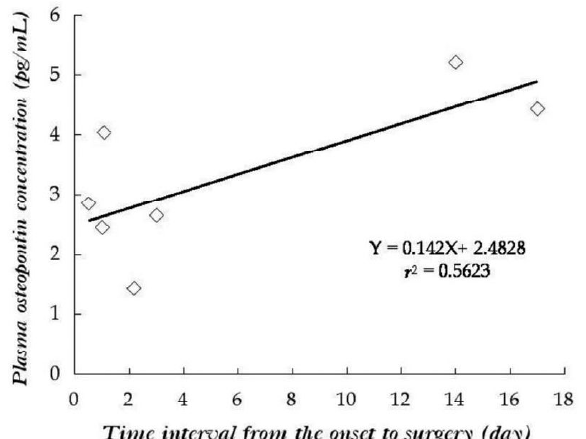
Fig. 8 - Correlation between plasma osteopontin concentration and time interval from the onset to surgery in the patients with aortic